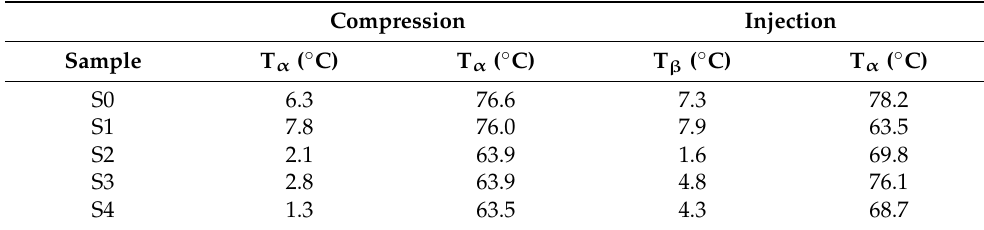
Table 7. Transition temperatures for the indicated